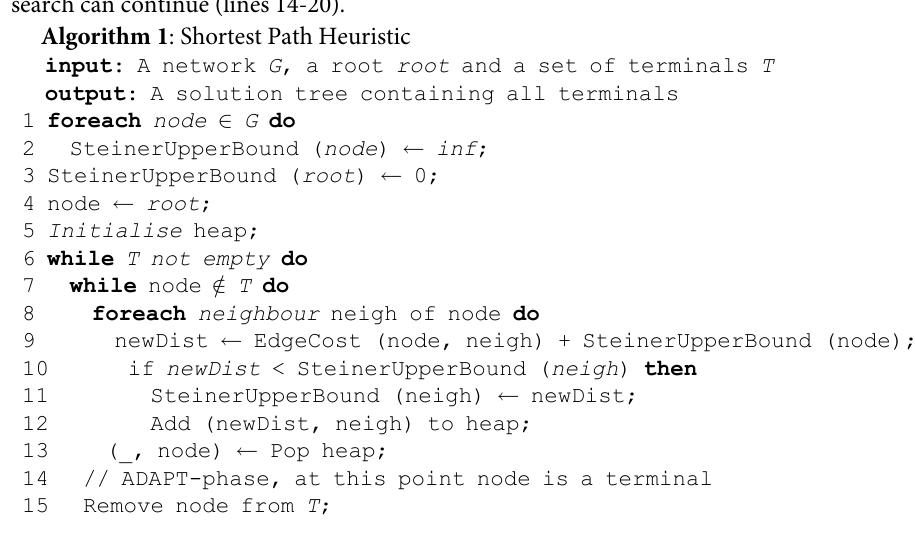
Algorithm 1 : Shortest Path